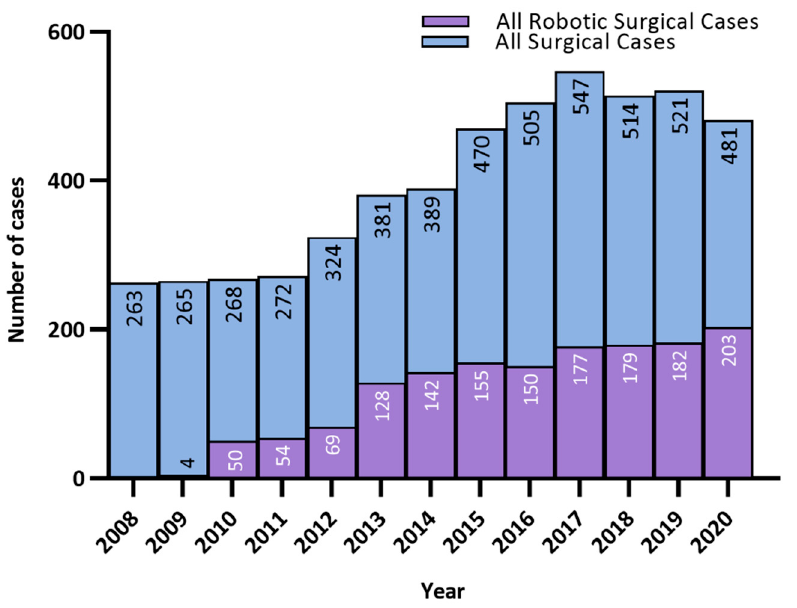
Figure 4. Growth in the use of Robotic Surgery at Royal Surrey NHS Foundation Trust, Guildford.